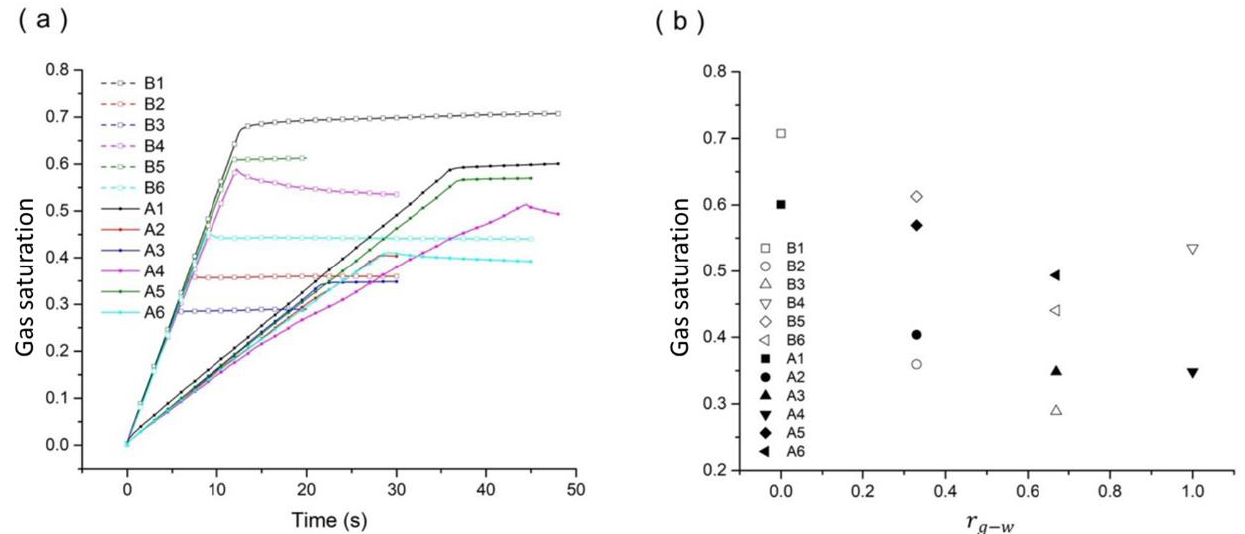
Figure 9. Variation of gas saturation as a function of time ( a ) and the ultimate gas saturation ( b ) in porous structures with various wetting conditions, where A1/B1 represents the full water-wet case with 𝑟 𝑔−𝑤 = 0, A2/B2 for continuous gas-wet with 𝑟 𝑔−𝑤 = 1/3; A3/B3 for continuous gas-wet with 𝑟 𝑔−𝑤 = 2/3, A4/B4 for the full gas-wet with 𝑟 𝑔−𝑤 = 1, A5/B5 for alternating gas-wet with 𝑟 𝑔−𝑤 = 1/3, A6/B6 for alternating gas-wet with 𝑟 𝑔−𝑤 = 2/3.